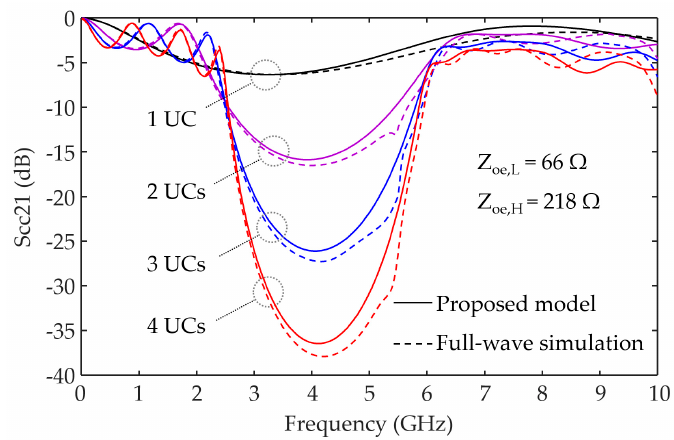
Figure 6. CM noise suppression with varying number of unit cells (UCs) for model verification.